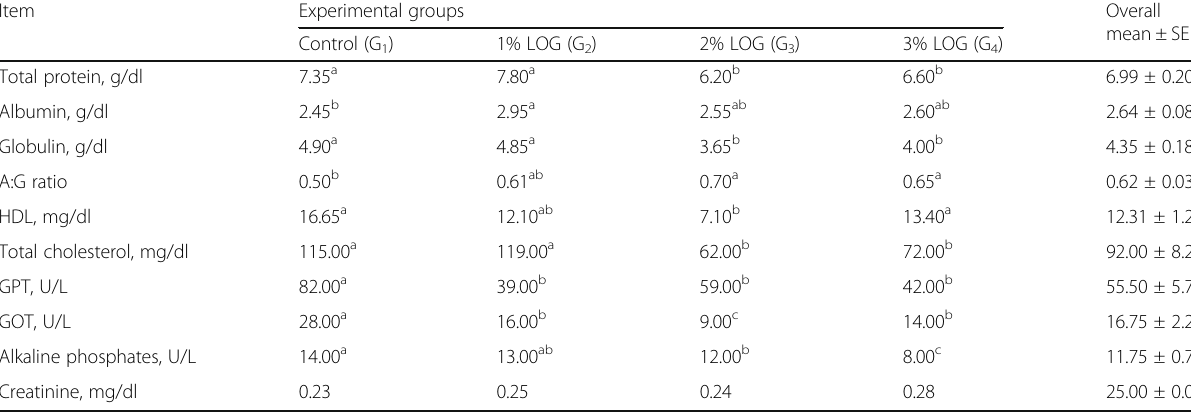
Table 5 Blood plasma constituents of laying hens fed with different dietary treatments Item Experimental